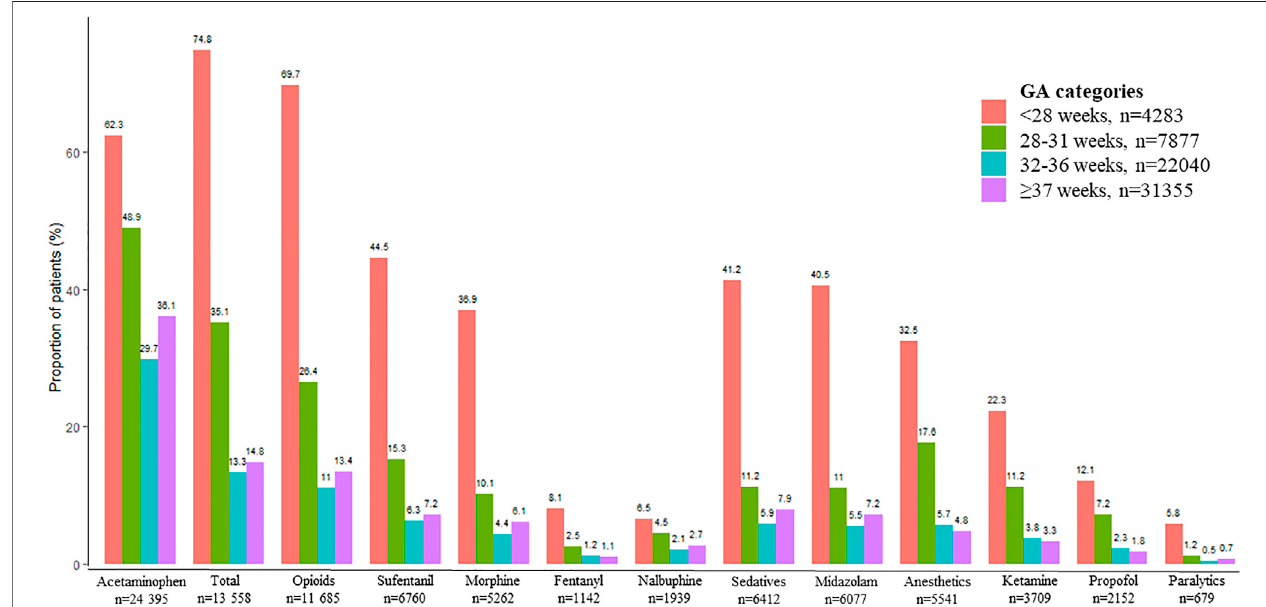
FIGURE 3 | Proportion of patients for each drug class or molecule according to gestational age (GA) group. Percentages were calculated with the total number of patients in each GA group as the denominator. “ Total ” represents the number of patients with at least one prescription of an analgesic, sedative, paralytic, and/or anesthetic agent except